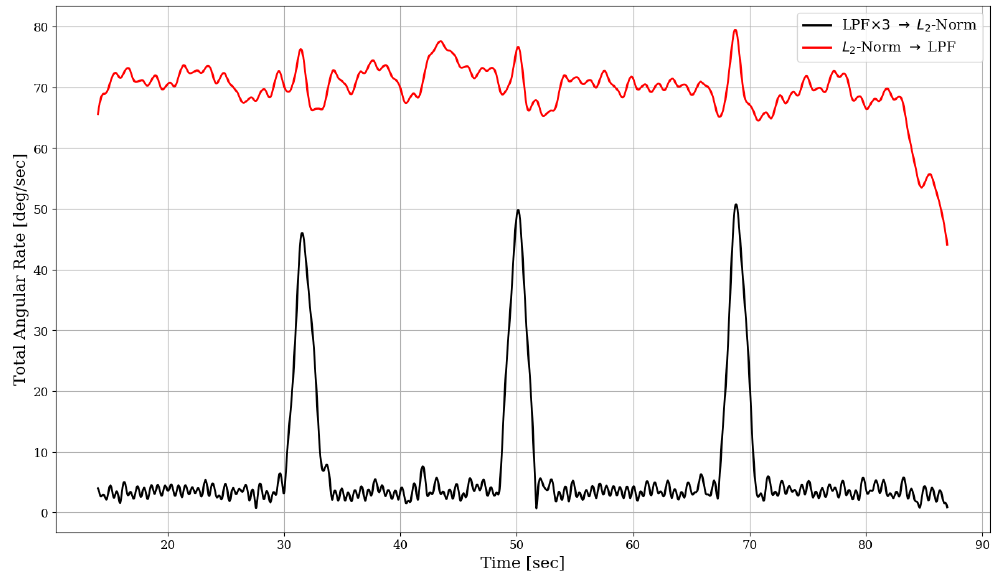
Figure 6. Magnitude of angular rate vector, comparing two different forms for sequential processing of the gyroscope raw